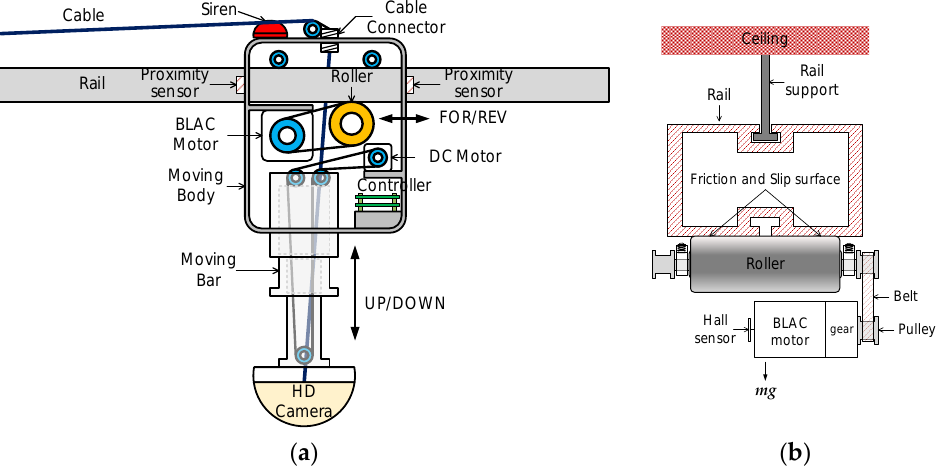
Figure 1. Conventional rail mover system: ( a ) overall structure; ( b ) mover traction with Brushless AC (BLAC) motor.